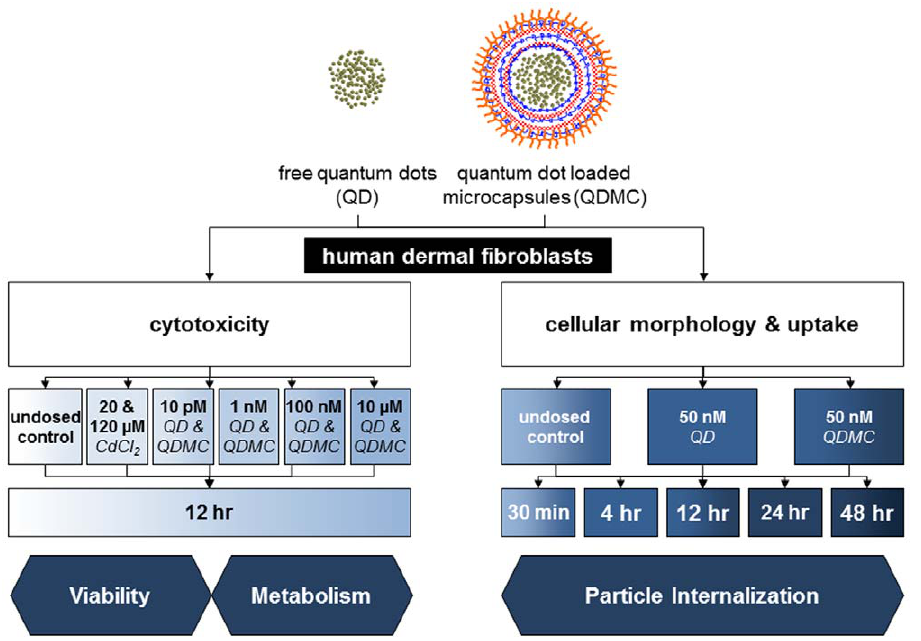
Figure 2. Experimental design. Flowchart of the protocol used for testing the cellular response (cytotoxicity and morphology) of human dermal fibroblasts (HDF) to free quantum dots (QD) and quantum dot loaded microcapsules (QDMC). Cultured cells were exposed to either QD or QDMC for all experiments. CdCl 2 was used in some experiments as a positive control. Cytotoxicity, including % dead, metabolism, and apoptosis, were determined over a dose-response, while cellular morphology and uptake were determined over a time course.